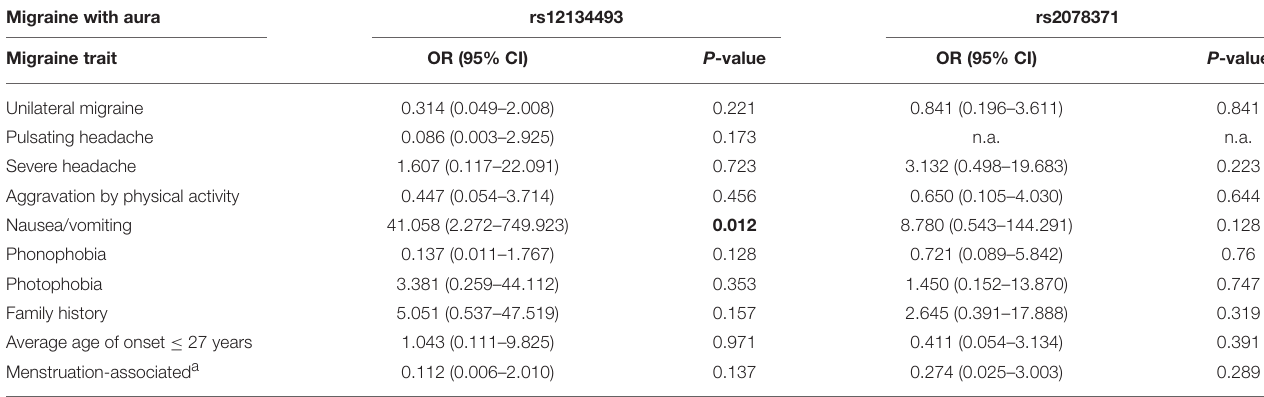
TABLE 6 | Genotype-phenotype association of the two SNPs and migraine features in MA group. Migraine with aura Migraine